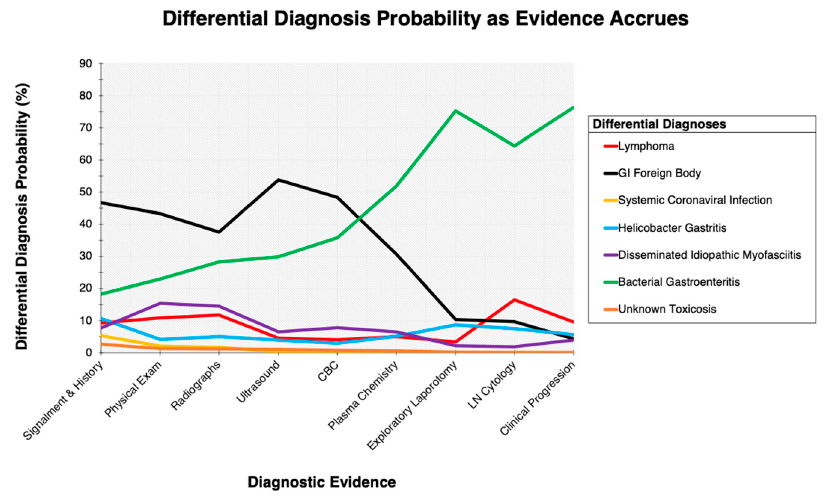
Figure 1. Each of seven differential diagnosis probabilities for a 1-year-old castrated male ferret that presented to a veterinary teaching hospital following two days of lethargy and inappetence, and one day of diarrhea. The cumulative composite posterior probabilities for each differential diagnosis change as each new piece of diagnostic evidence is incorporated into the clinical picture.